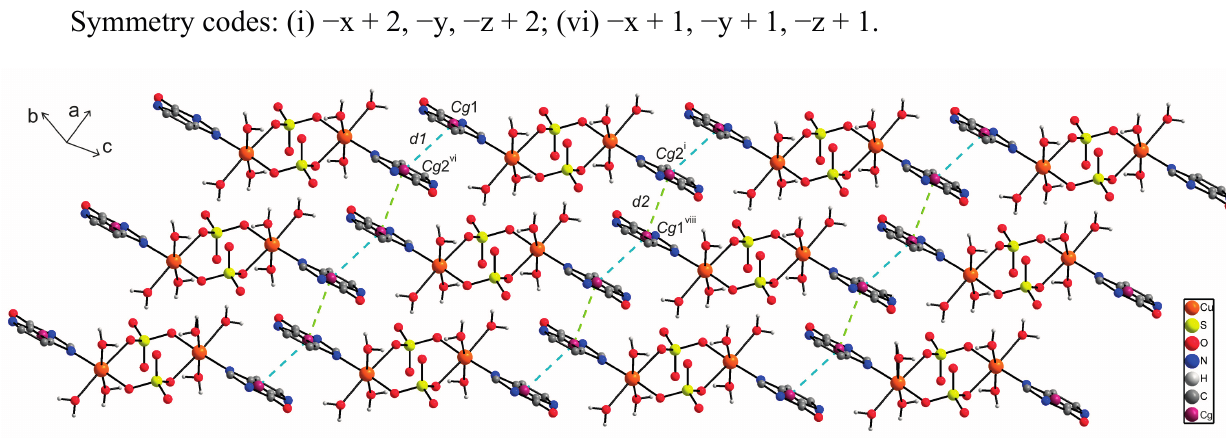
Figure 2. A part of the crystal structure of [{Cu(9dhx)(H 2 O) 3 } 2 (µ-SO 4 ) 2 ] ( 1 ), showing the formation of supramolecular polymeric chains, with depicted hydrogen bonds (blue dashed lines) O(3)–H(3W)···O(9), O(4)–H(4W)···O(9) i and O2–H2W···O1 vi . Hydrogen atoms, except for the hydrogen atoms participating in hydrogen bonds, are omitted for clarity.